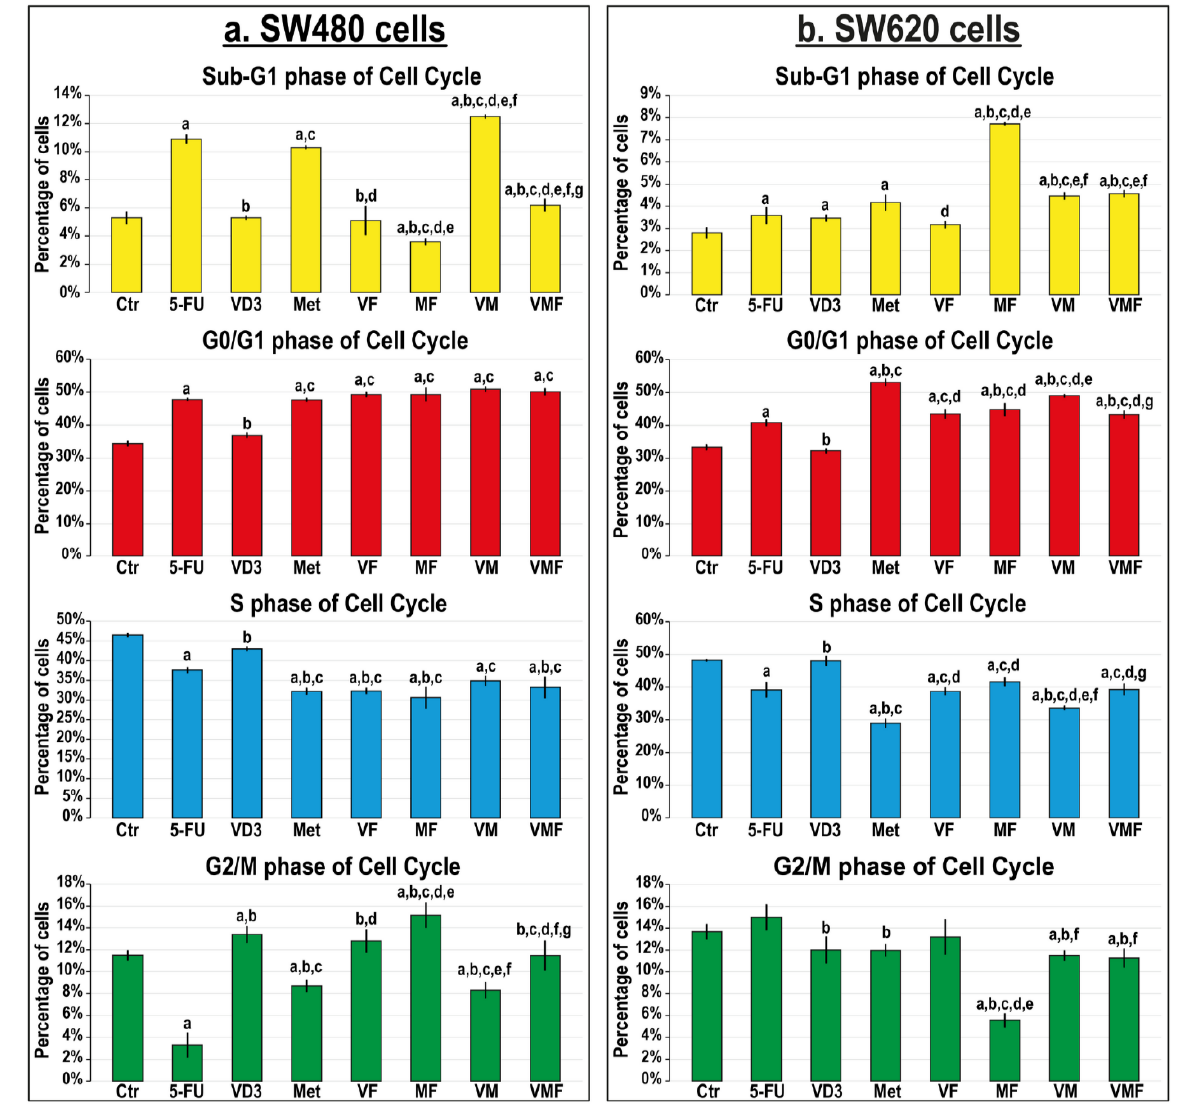
Figure 3. Percentages of cells (mean ± SD) in the different phases of the cell cycle in untreated control cells, and following treatments with 5-fluorouracil, calcitriol, and/or metformin single (5-FU, VD 3 , and Met), dual (VF, MF, and VM), and triple (VMF) therapies for 12 h in the ( a ) SW480 and ( b ) SW620 colon cancer cell lines (n = 3/group; data were analysed by ANOVA followed by Games–Howell post hoc tests and are shown as the mean ± SD; a = p < 0.05 compared with control untreated cells; b = p < 0.05 compared with 5-FU monotherapy; c = p < 0.05 compared VD 3 monotherapy; d = p < 0.05 compared with Met monotherapy; e = p < 0.05 compared with VF dual therapy; f = p < 0.05 compared with MF dual therapy; and g = p < 0.05 compared with VM dual therapy).